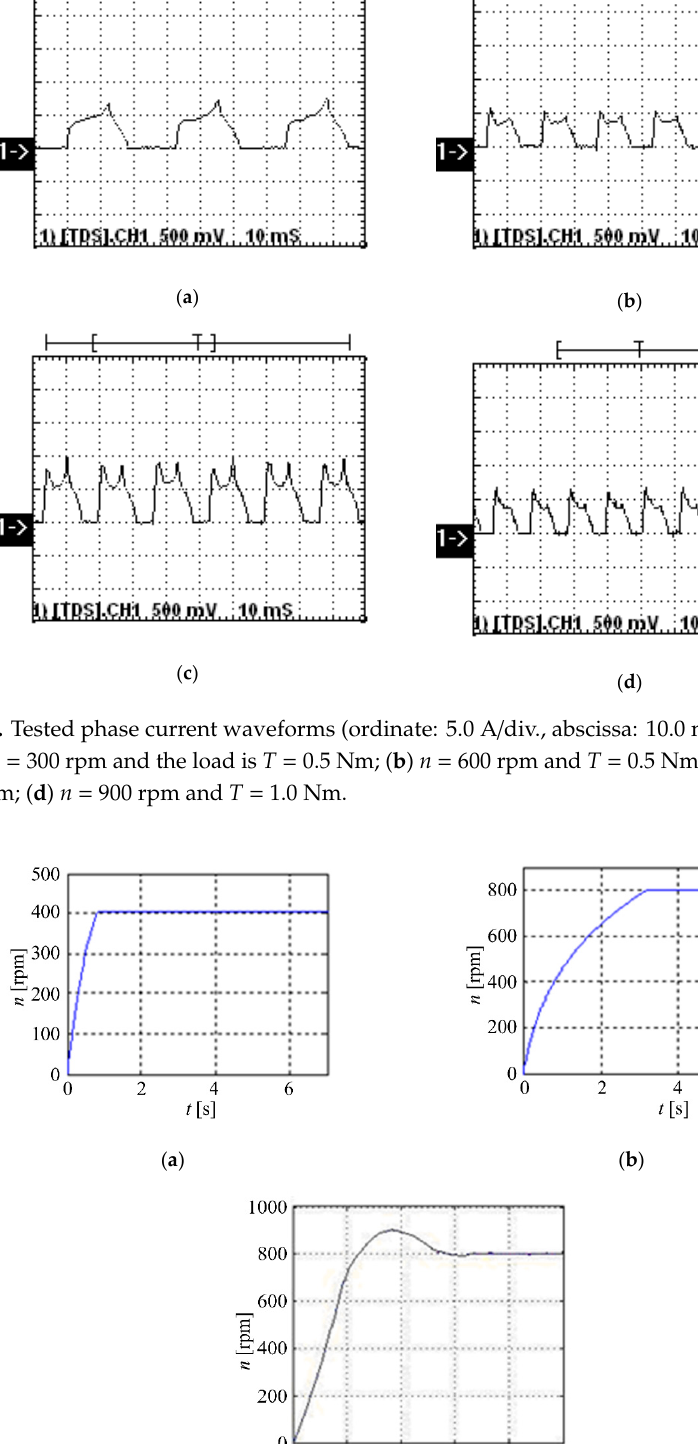
Figure 16. Phase current waveforms of the analyzed SRM machine: ( a ) the rotor speed is n = 300 rpm and the load is T = 0.5 Nm; ( b ) n = 600 rpm and T = 0.5 Nm; ( c ) n = 600 rpm and T = 1.0 Nm; ( d ) n = 900 rpm and T = 1.0 Nm.